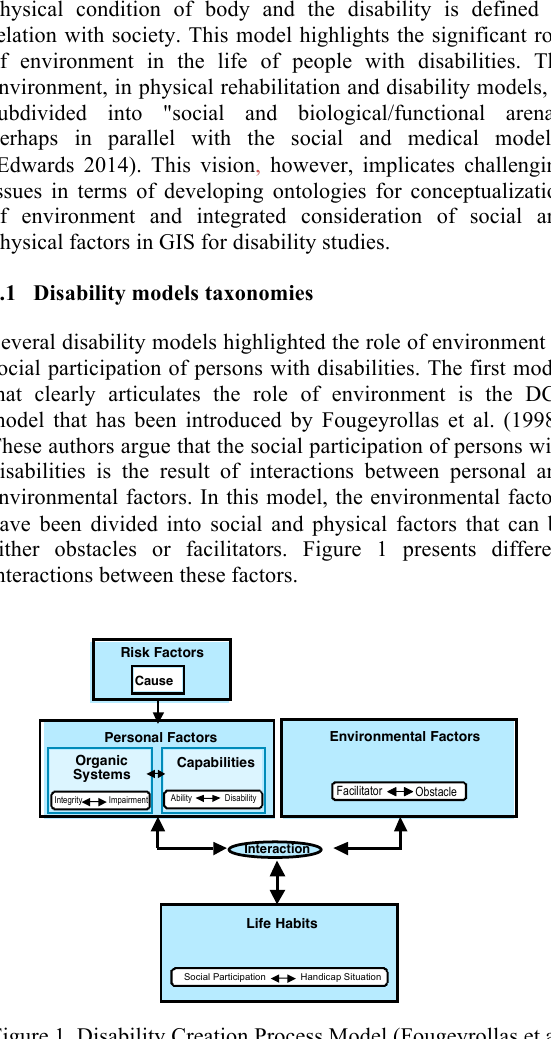
Figure 1. Disability Creation Process Model (Fougeyrollas et al. (1998))